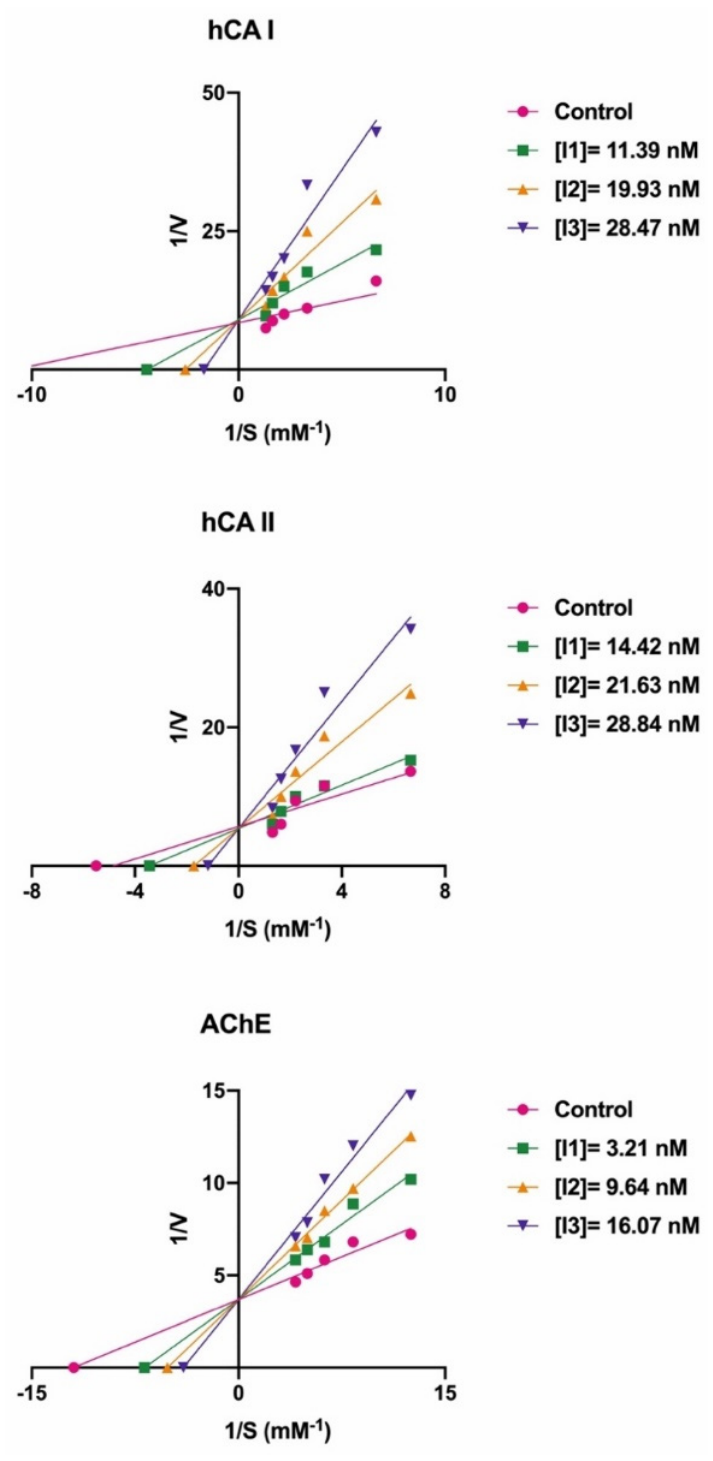
Figure 2. The Lineweaver–Burk plots of novel bromophenol compounds ( 14 for hCA I, 13 for hCA II, and 21 for AChE). Table 1. Inhibition parameters of the novel synthesized bromophenols (13 – 21) against AChE, hCA I, and hCA II enzymes.